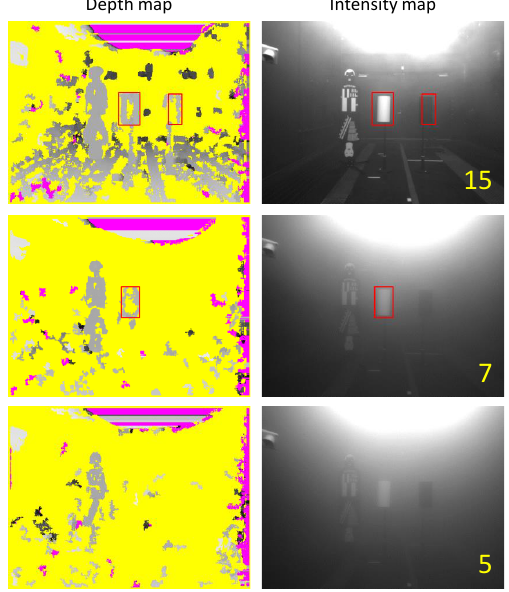
Figure 17. Experiment results by the emulated ESPE sensor,